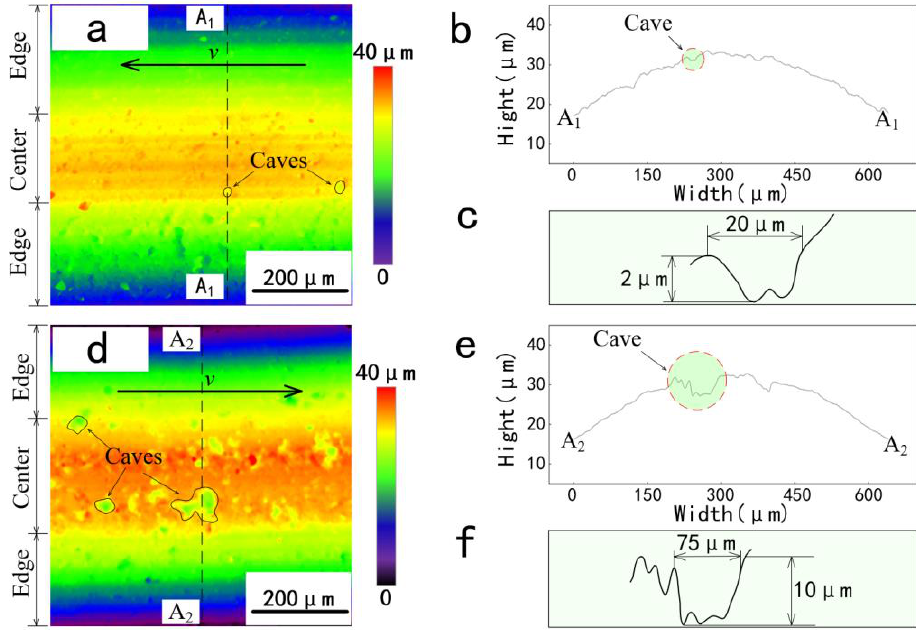
Figure 5. Top views of the three-dimensional topography of ( a ) untreated specimens and ( d ) treated specimens after wear tests and their two-dimensional profiles of ( b , e ) worn scars (marked with dashed lines A 1 -A 1 and A 2 -A 2 ) and ( c , f ) caves.